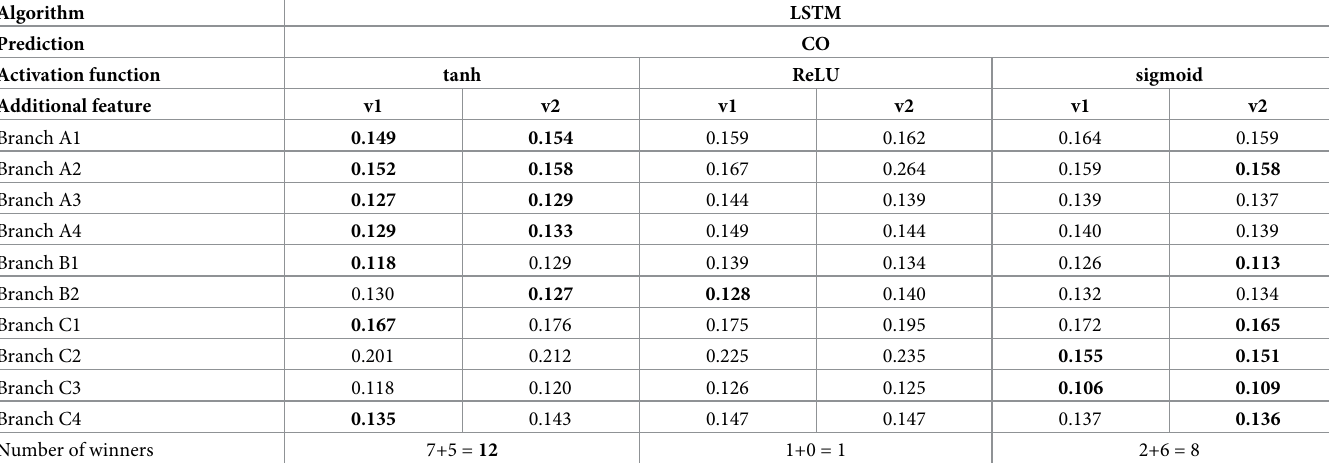
Table 7. RMSE results of CO predictions by using LSTM with different activation functions.